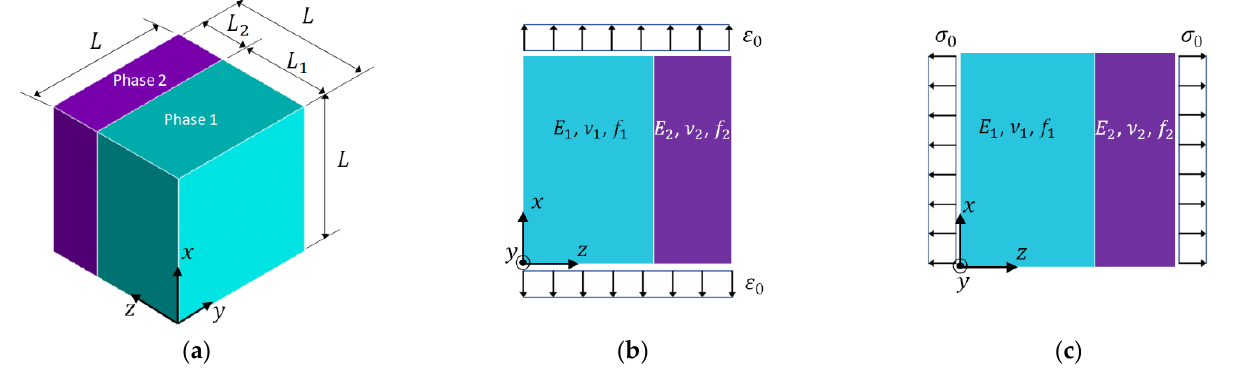
Figure 1. ( a ) Composite RVE; ( b ) iso-strain condition; ( c ) iso-stress condition. Table 1. Symbols of the involved parameters and variables .